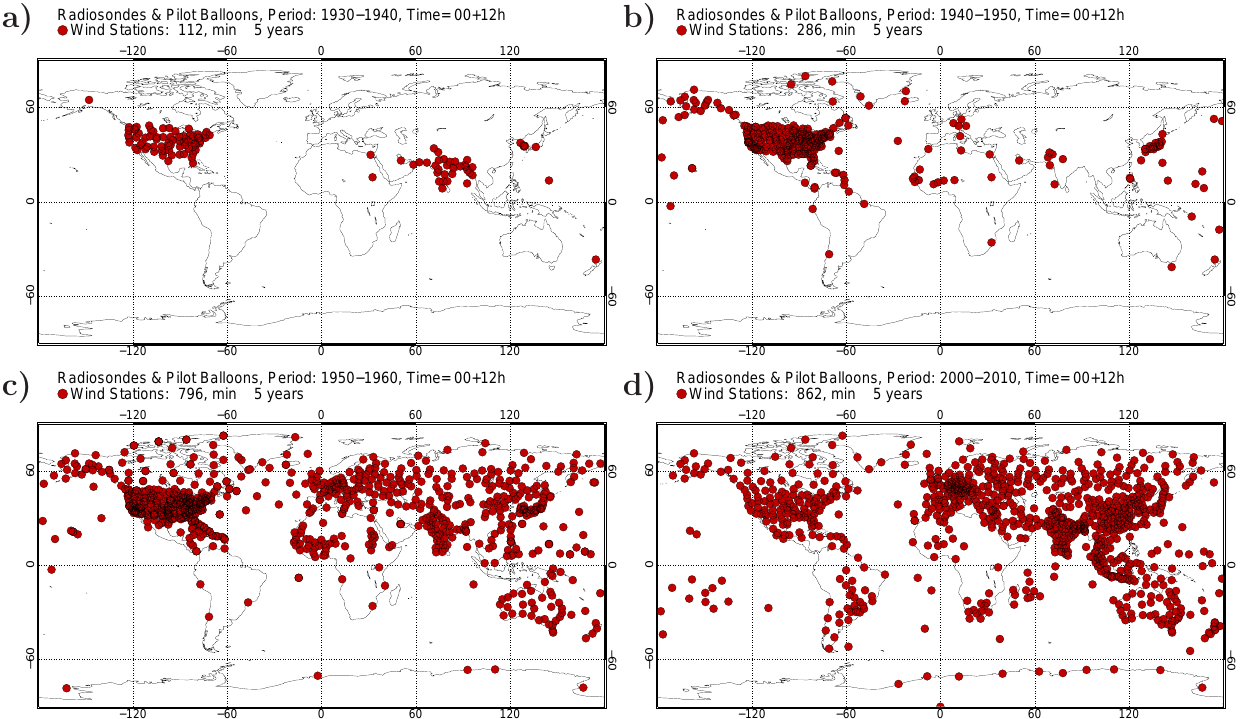
Figure 1. Maps of upper-air stations of the GRASP data set with at least 5 years of data per decade in the range of 850–500hPa for different decades.